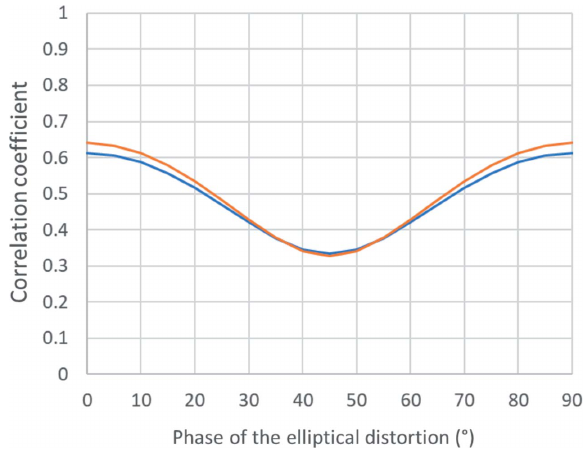
Figure 10 The correlation coefficient for the elliptical distortion as a function of the phase of the elliptical distortion in the case of two crystals mutually rotated by 90 (cid:2) for (cid:2) max of 20 (cid:2) (blue) and 60 (cid:2)